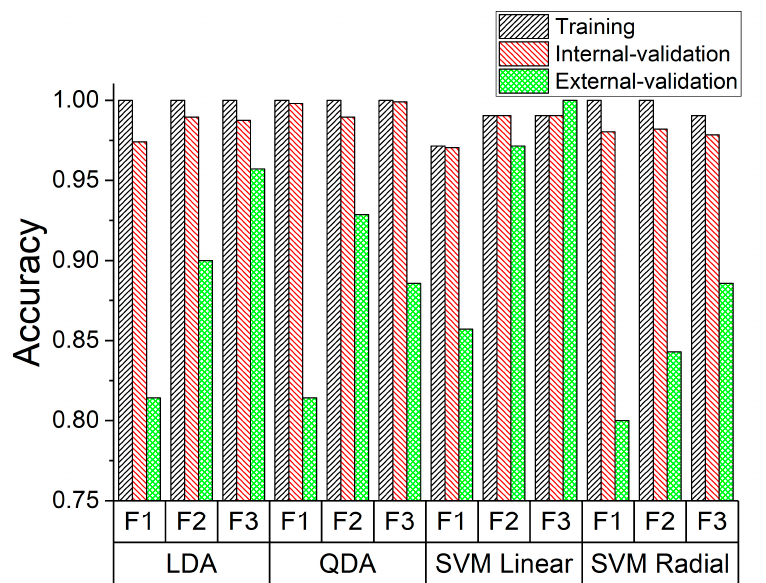
Figure 6. Accuracy achieved for training (black bars), internal validation using the repeated K-fold-CV procedure (10 repeats and 10 folds, red bars), and external-validation (testing dataset, green bars) for the combinations of supervised pattern recognition tool (LDA, QDA, SVM-linear or SVM-radial) and data preprocessing method ( F 1, F 2 or F 3). Table 3. Sensitivity values (correct classification rate, i.e., true positive rate) achieved for the external validation dataset (testing dataset), per grouping class.